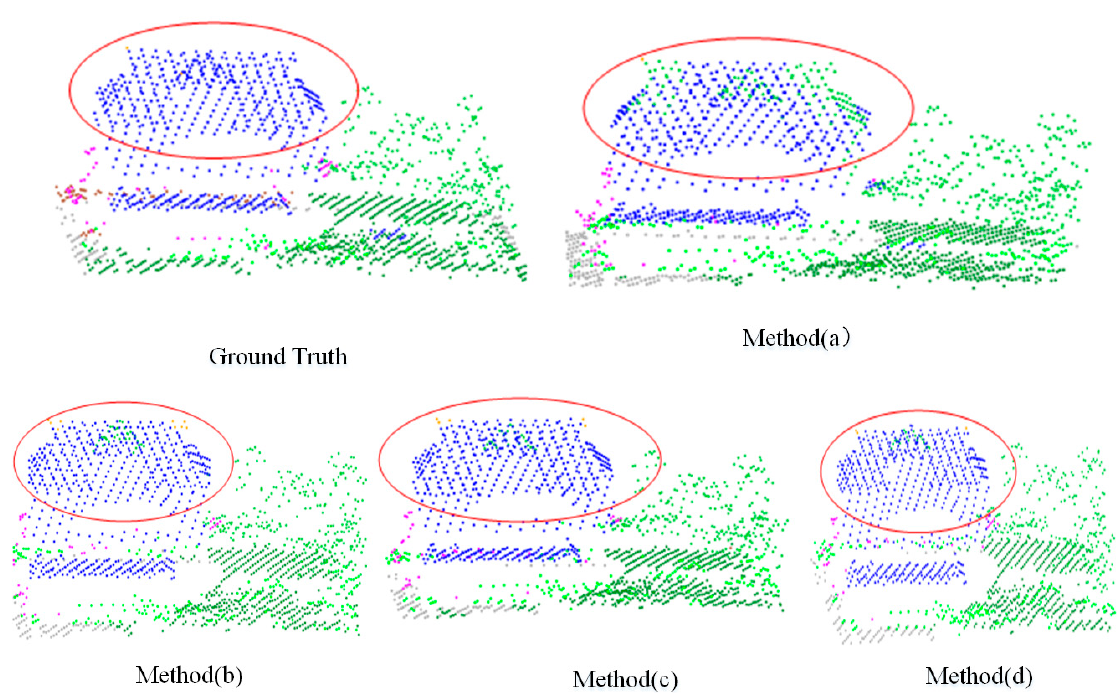
Figure 5. The performance of different proportions elevation information on interpolation.